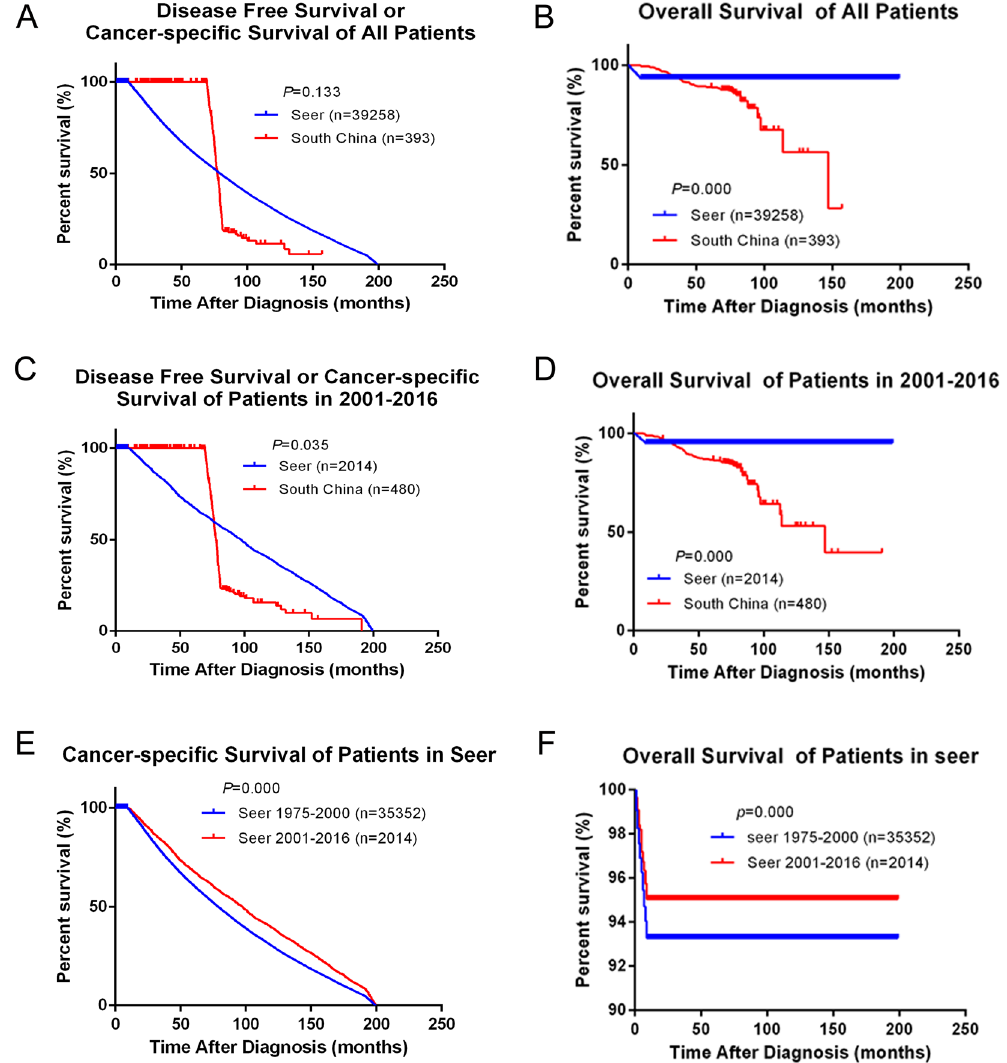
Figure 2. Comparison of all patients’ DFS, CSS and OS in Southern China and SEER database. ( A , B ) Kaplan– Meier estimates disease-free survival (DFS), cancer-specific survival (CSS) and overall survival (OS) of all patients in both Southern China and SEER database, ( C , D ) Kaplan–Meier estimates DFS or CSS and OS of patients in 2001–2016 in both Southern China and SEER database, ( E , F ) Kaplan–Meier estimates DFS or CSS and OS in both 1975–2000 and 2001–2016 in SEER